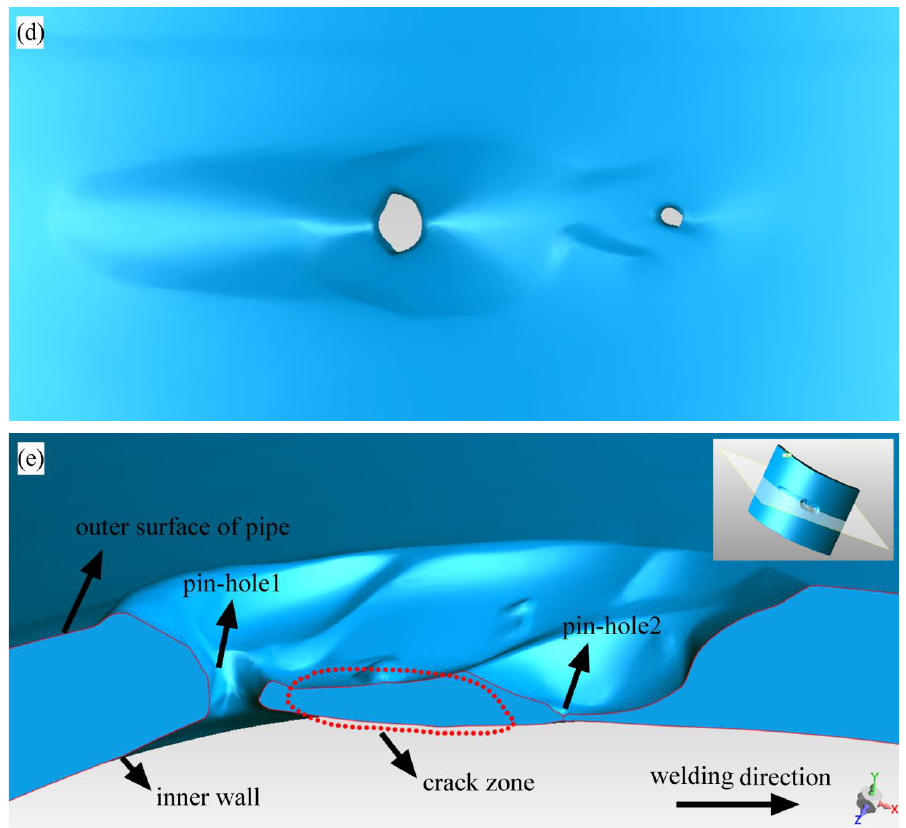
Figure 11. Macroscopic morphology and contours near the burn-through zone of 24E-1: ( a ) contour of the upside; ( b ) contour of the backside; ( c ) macroscopic morphology of the upside; ( d ) macroscopic morphology of the backside; ( e ) sectional view.